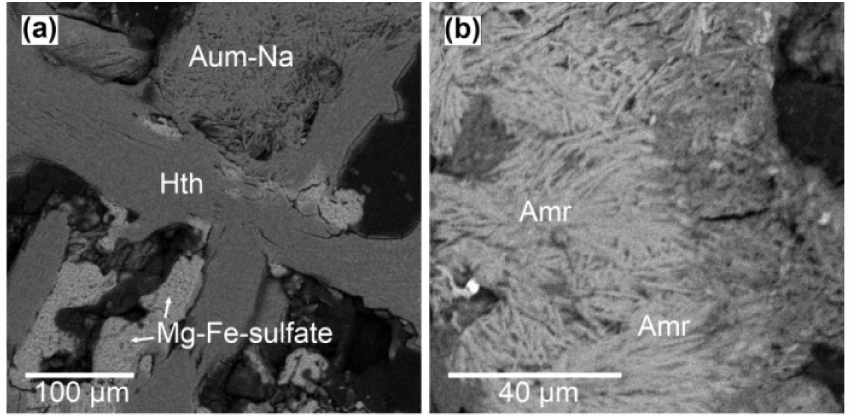
Figure 6. BSE images of ( a ) alum-(Na), (aum-Na), and ( b ) amarillite (Amr) from Dachnoe thermal field.